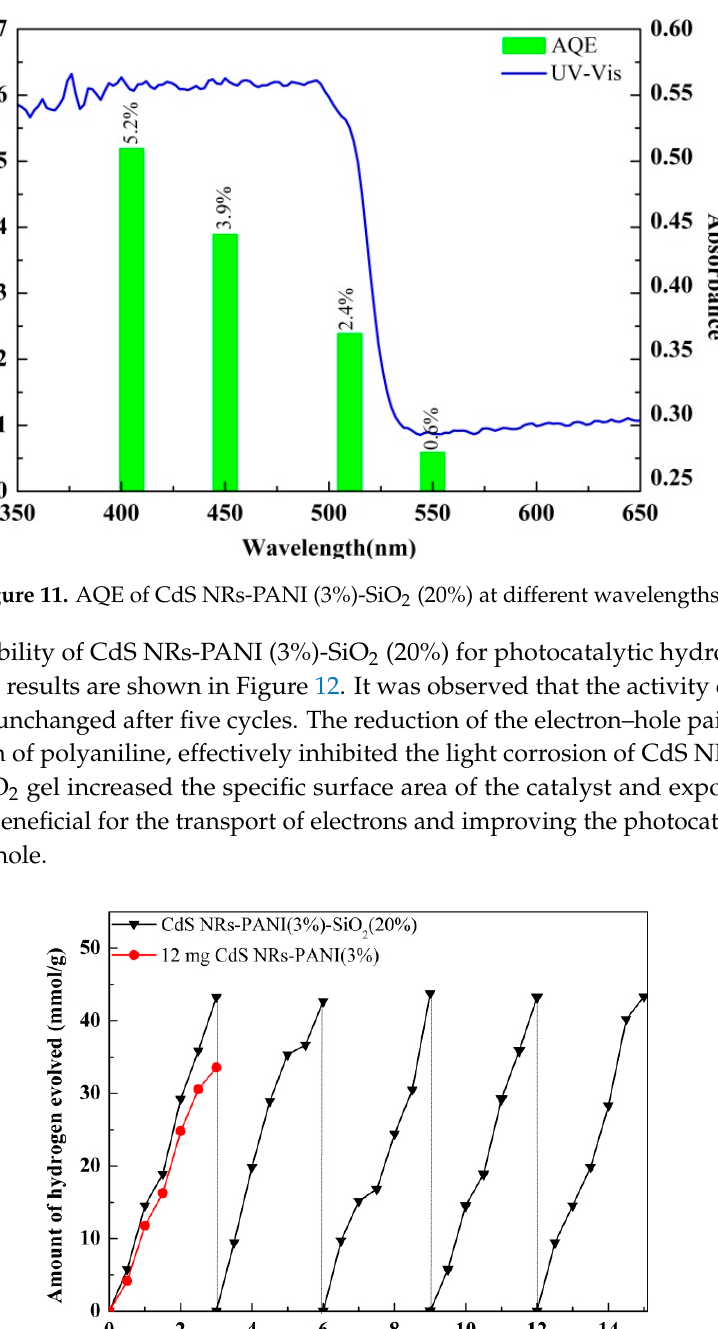
Figure 12. CdS NRs-PANI (3%)-SiO 2 (20%) photo-catalytic hydrogen production cycle test.